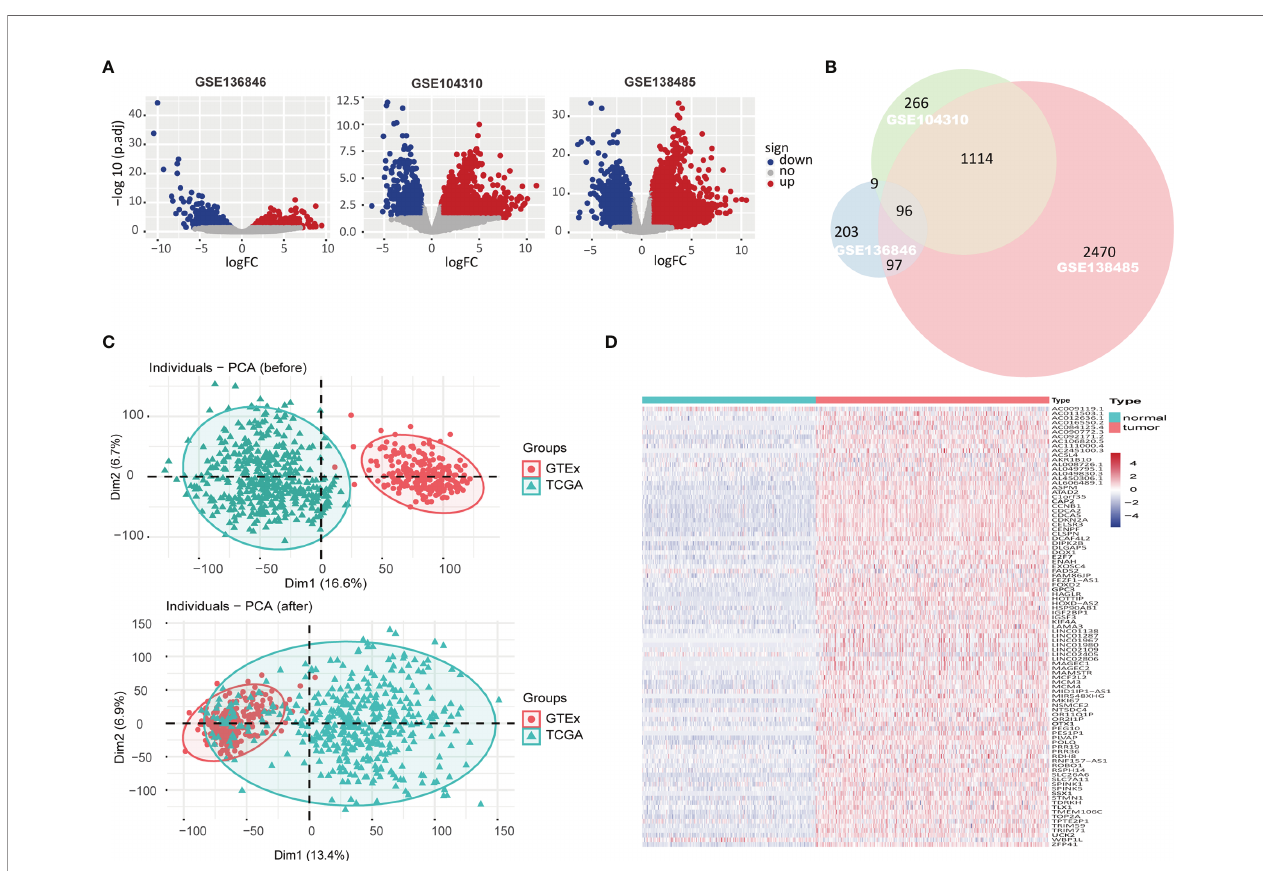
FIGURE 1 | The upregulated differentially expressed genes (DEGs) in hepatocellular carcinoma (HCC) datasets. (A) Volcano plot showed gene expression in GSE136846, GSE104310, GSE138485 datasets with red/blue marker classi fi cation of upregulated/downregulated genes based on the criteria of |log2FoldChange| >1 and adjust p-value <0.05. (B) Venn diagram showed the overlap of signi fi cantly upregulated DEGs in GSE136846, GSE104310, and GSE138485 datasets. (C) Principal component analysis (PCA) illustrated the merging of Genotype-Tissue Expression (GTEx) and The Cancer Genome Atlas (TCGA) data before and after removal of batch effects. (D) In the merged GTEx and TCGA data, the expression matrix of 96 upregulated DEGs was subjected to unsupervised hierarchical clustering, with blue, red, and white representing lower, higher, and no expression differences between genes,